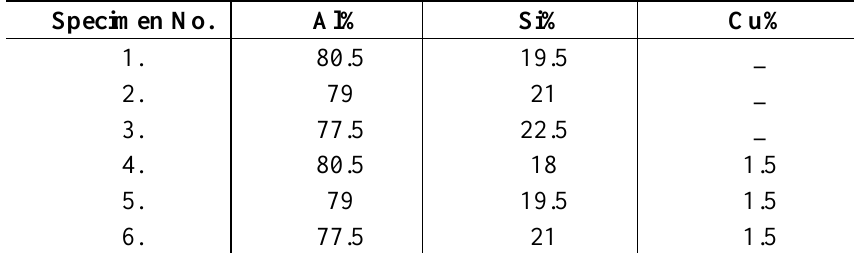
Table 1: Weight fractions related to different elements existing in